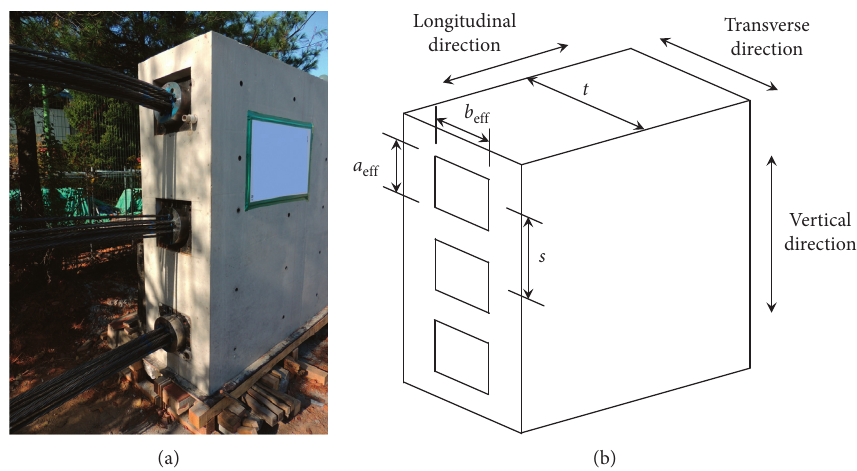
Figure 1: Anchorages of a PSC girder: (a) anchorages before tensioning; (b)